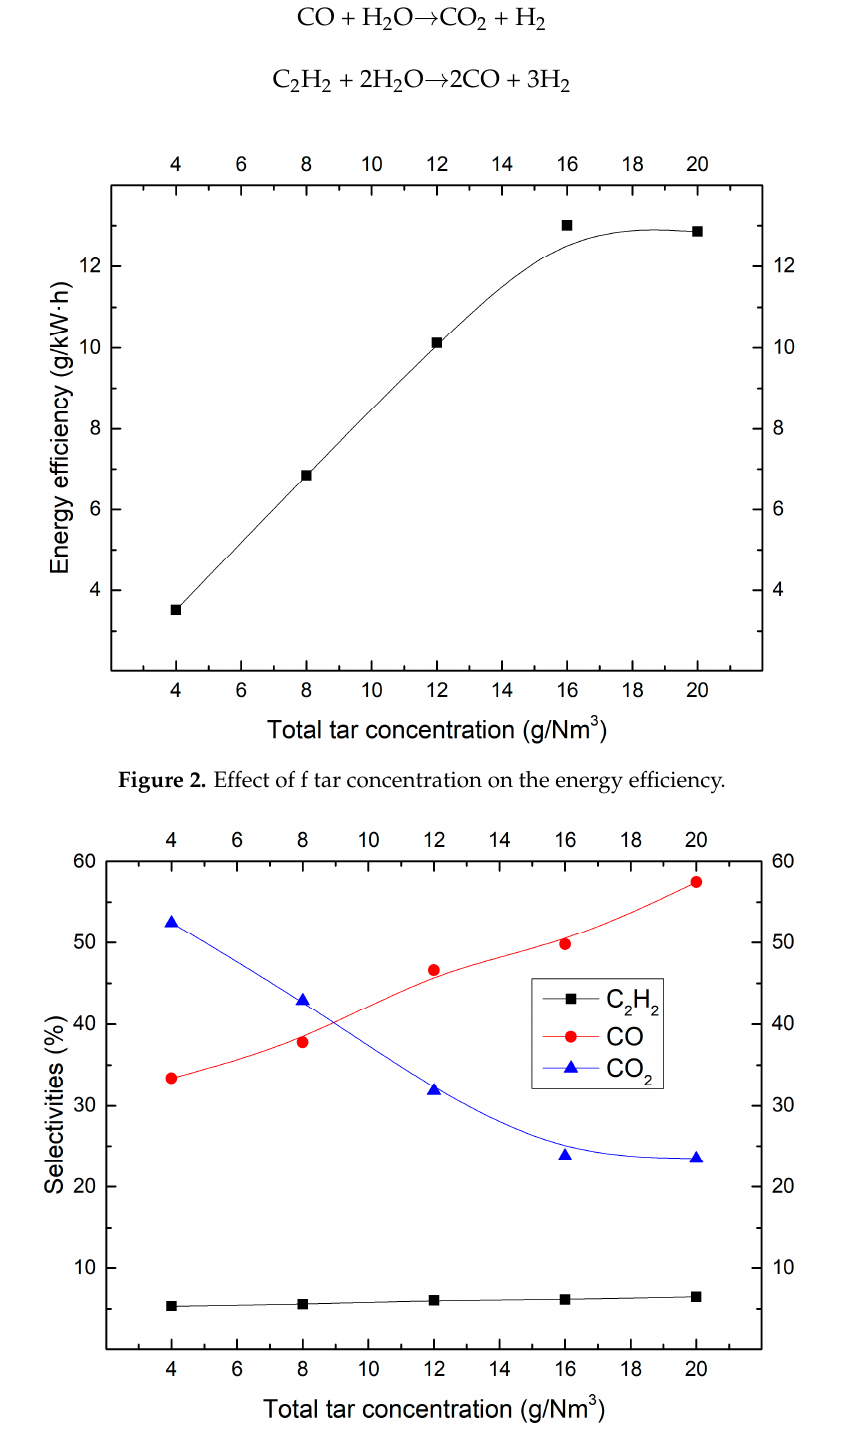
Figure 4. Effect of tar concentration on the composition of the off-gas. 2.2. Effect of Moisture Content Figure 5 indicates that as the moisture concentration increases, the destruction efficiency of toluene, naphthalene, and phenanthrene increases first to a maximum at a moisture concentration of 8% or 12% and then starts decreasing. Previous studies by Zhu et al. [36] and Chun et al. [39] showed a similar phenomenon for the decomposition of tar surrogate using gliding arc. The proper amount